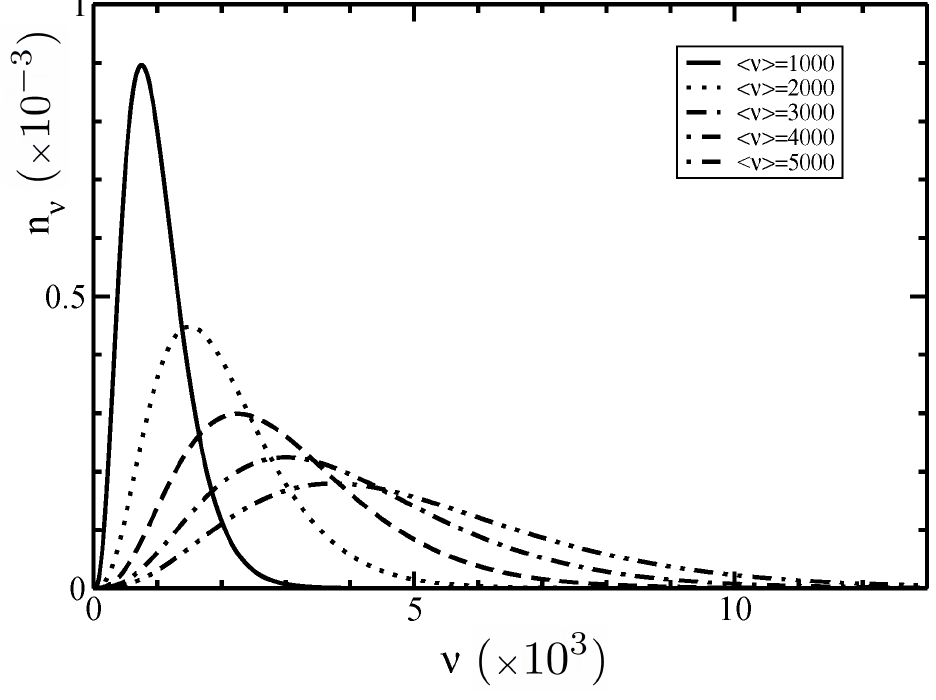
Figure 1. Schulz length distribution function n ν as a function of the filament size ν for different average sizes < ν > from Equation (40). The normalized standard deviation is σ = 0.5 ( z =